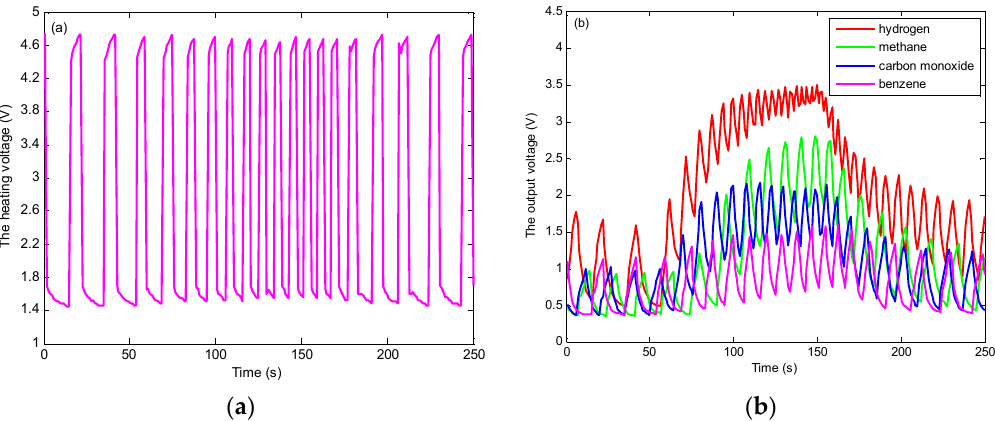
Figure 3. ( a ) The heating voltage of 30 ppm benzene; ( b ) The output voltages of 3000 ppm hydrogen, 3000 ppm methane, 300 ppm carbon monoxide, and 30 ppm benzene.